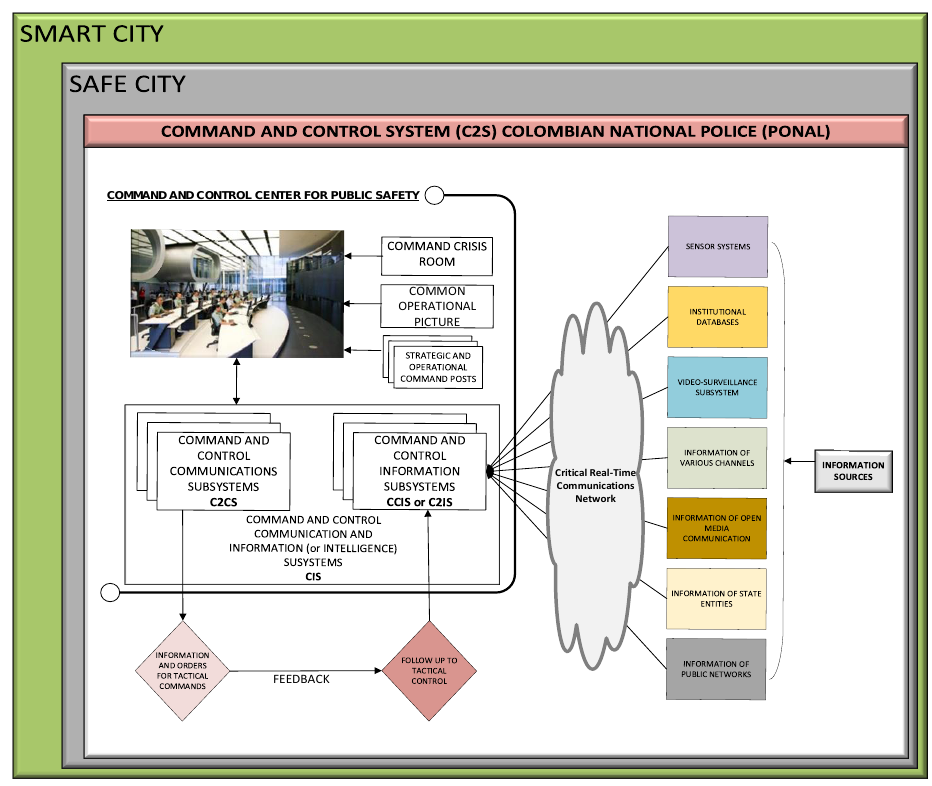
Figure 1. Safe City Projection, Colombian National Police.